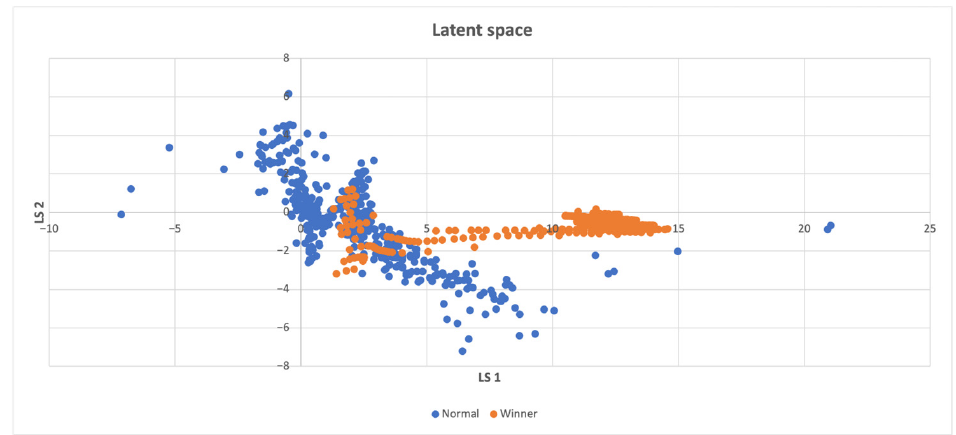
Figure 5. Latent space of the CartPole-v1 environment, the winning states usually differ from the normal ones, implying that discovering novel states is more likely to result in successful completion of the task.